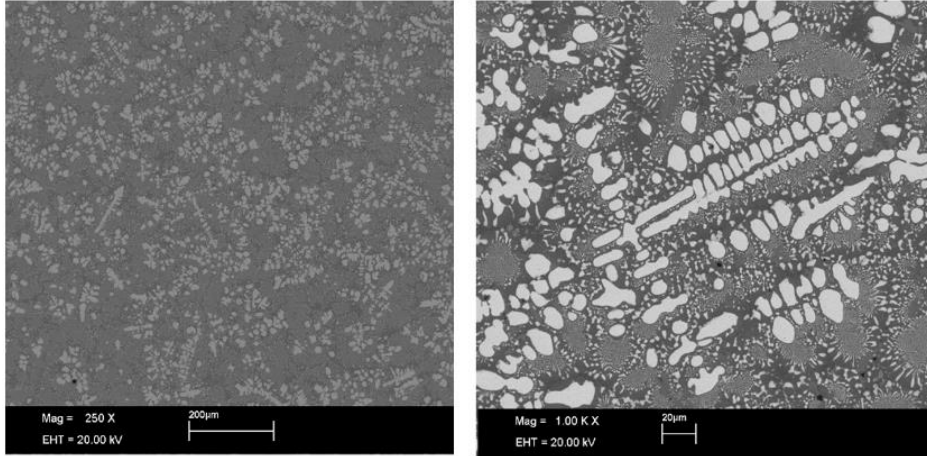
Figure 1. SEM micrographs of the as-cast Ni 33 Ti 39 Nb 28 sample with different magnifications.